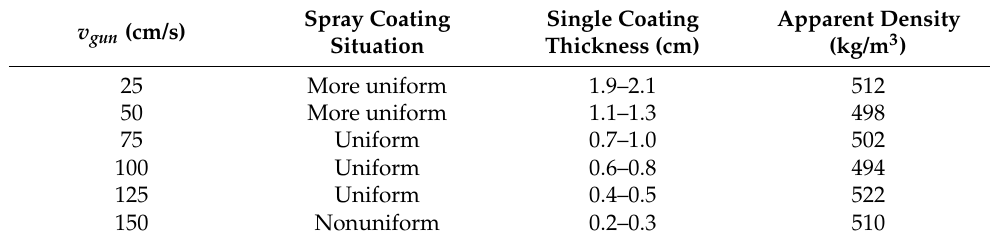
Table 4. Spray coating properties at different v gun .